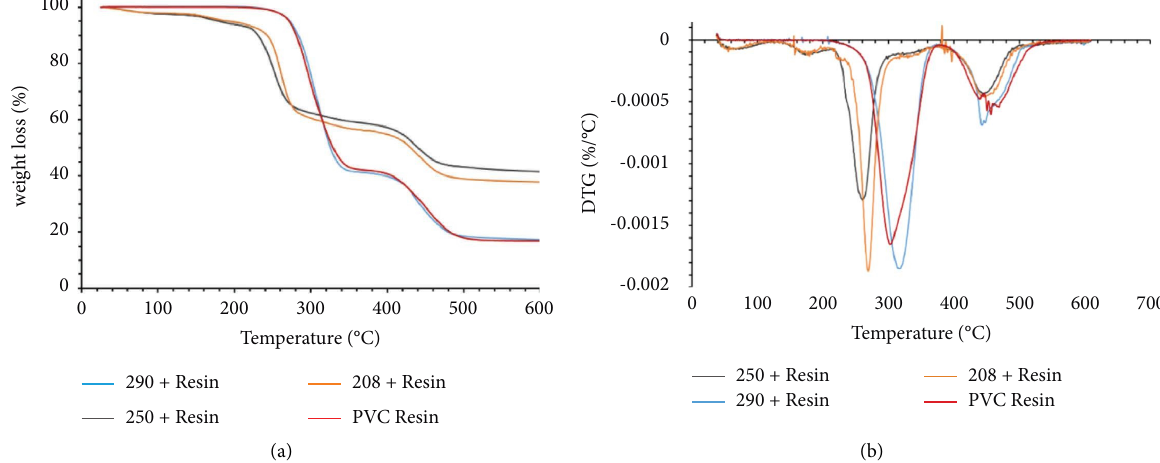
Figure 3: Termal analysis of remaining PVC (a) TGA curves, and (b) the frst order derivative of TGA curves of dried PVC after bacterial exposure with the three selected strains. PVC resin was used as the negative